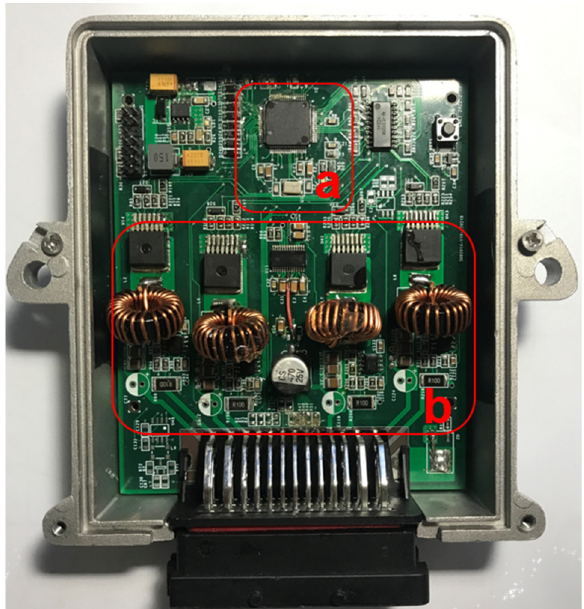
Figure 11. Current driver physical diagram: ( a ) DSP core; ( b ) 4-channel current output circuit.